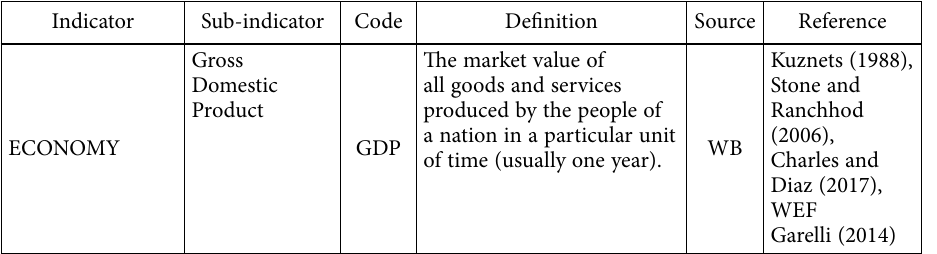
Table 1. Definition of